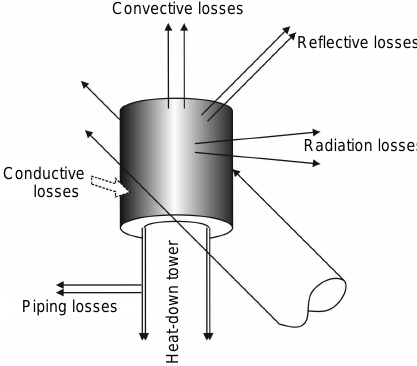
Figure 4. Receiver energy balance (adapted from Gorjan et al.,